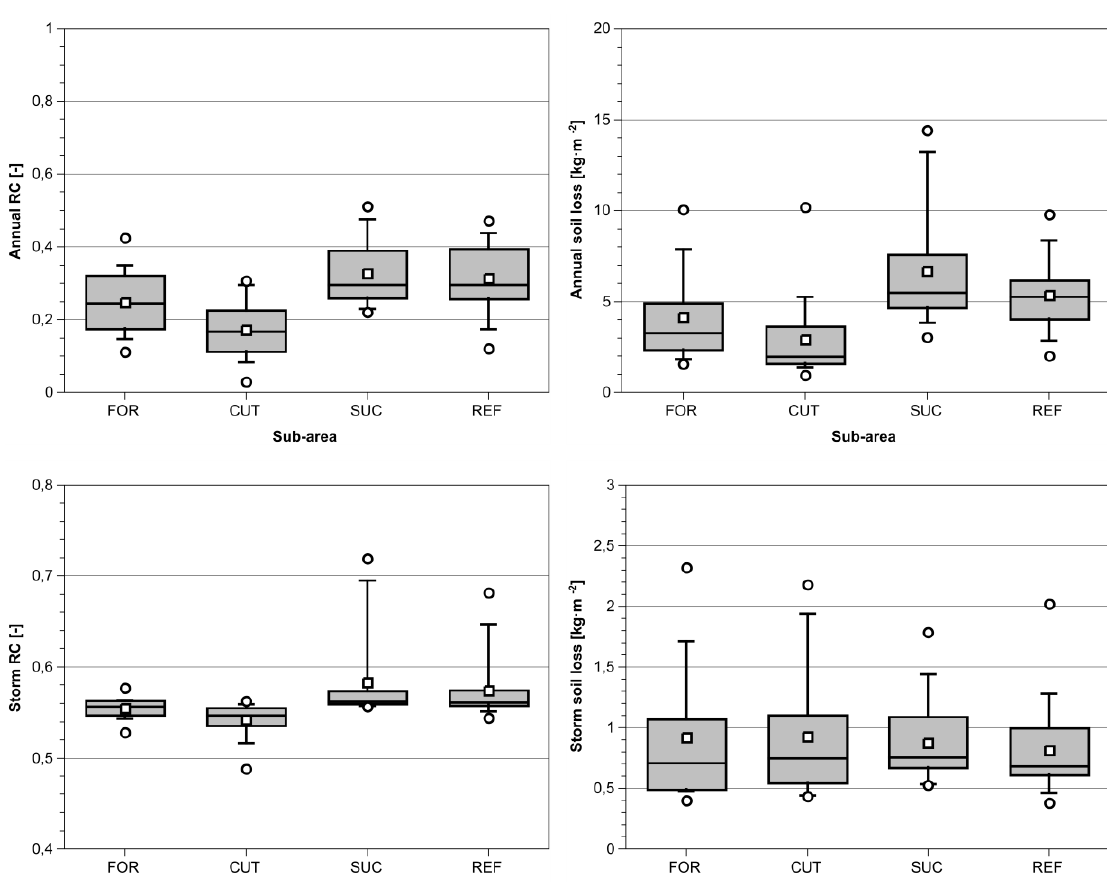
Figure 12. Dataset distribution of standardized modeling for every sub-area, viewing at singular soil samples; (FOR)est, (CUT)-down, (SUC)cession, (REF)forested.